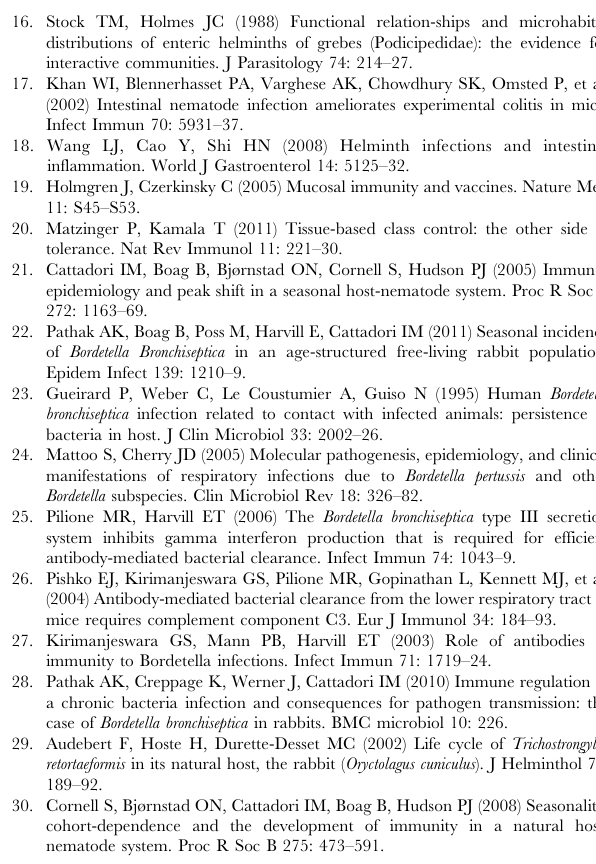
Table S2 Relationship between T. retortaeformis abundance (worm/duodenum length) and immune variables from the co- infection experiment. A- Summary of the Principal Component Analysis (PCA) based on the most representative immune variables; only the first two PCA axes are reported. Note that the cytokine Ct values are inversely related to the level of expression. B- Summary of the generalized linear model (GLM) between helminth abundance and PCA axis 1 and axis